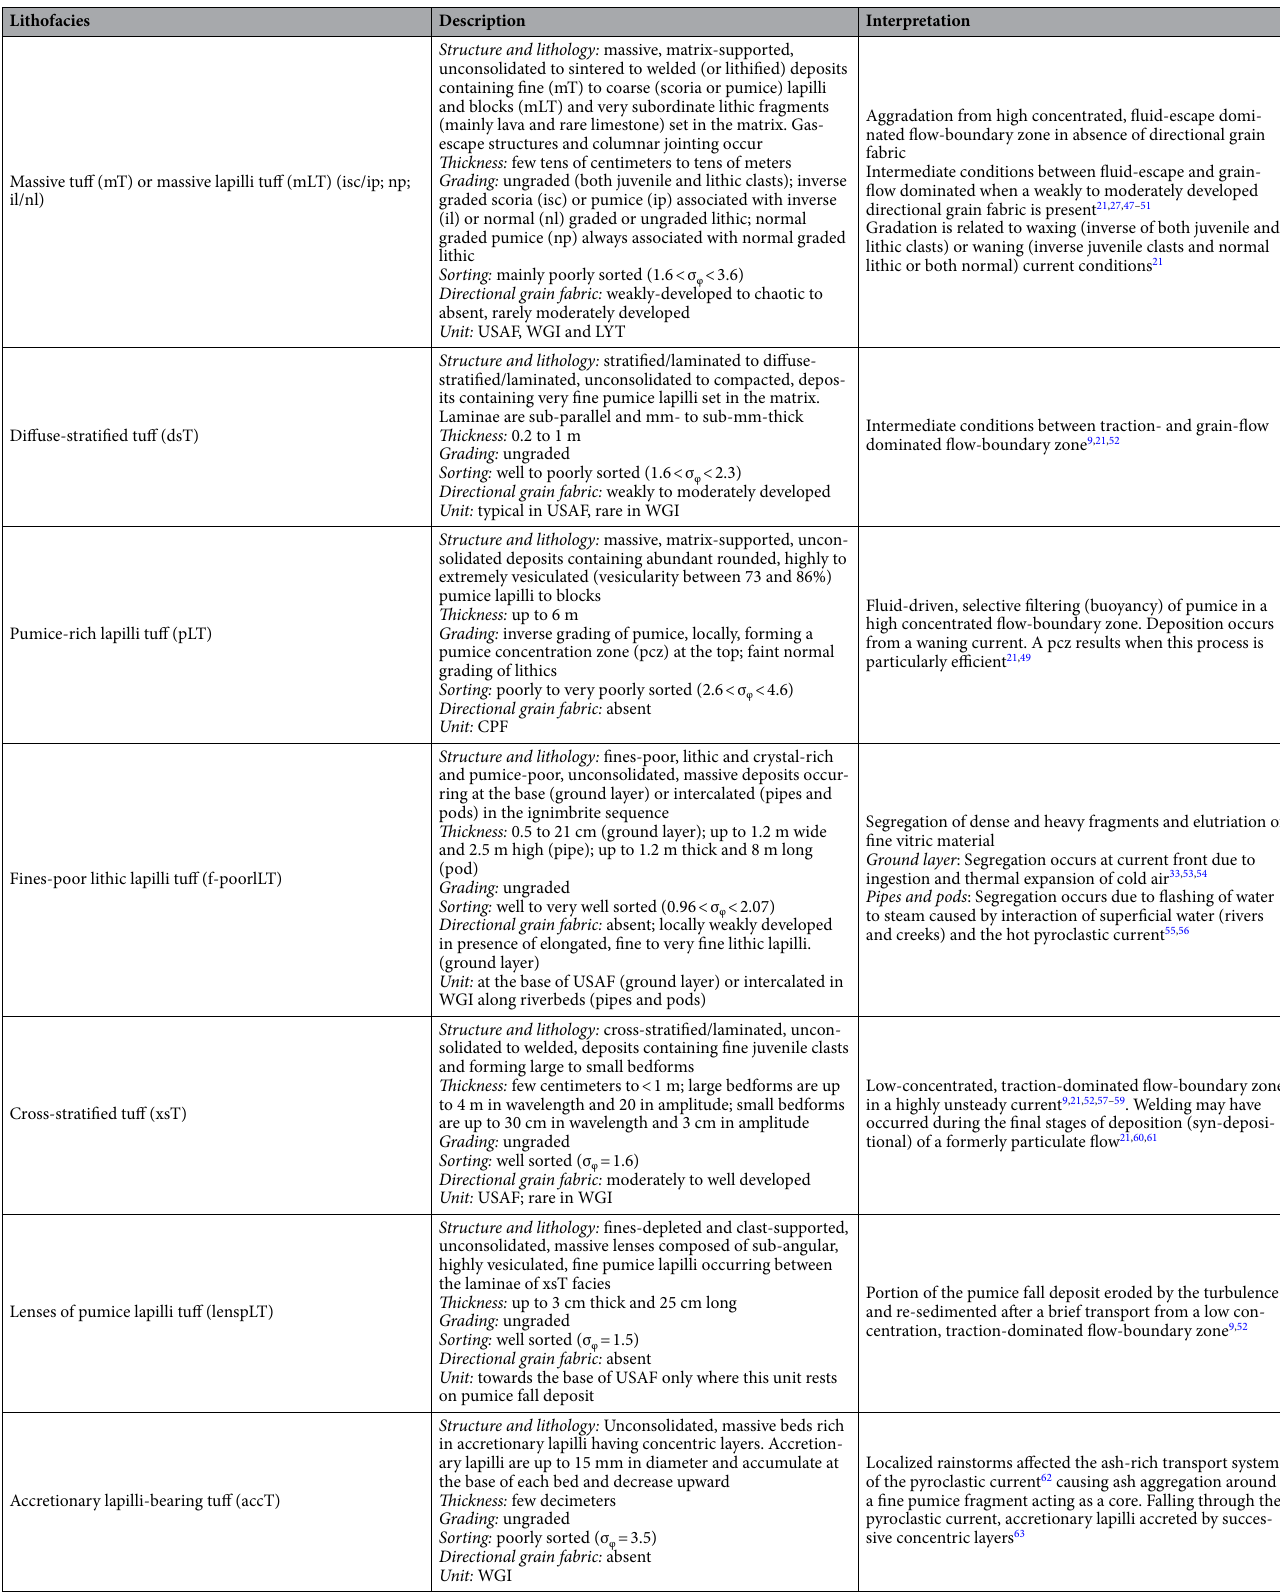
Table 1. Summary description and interpretation of CI